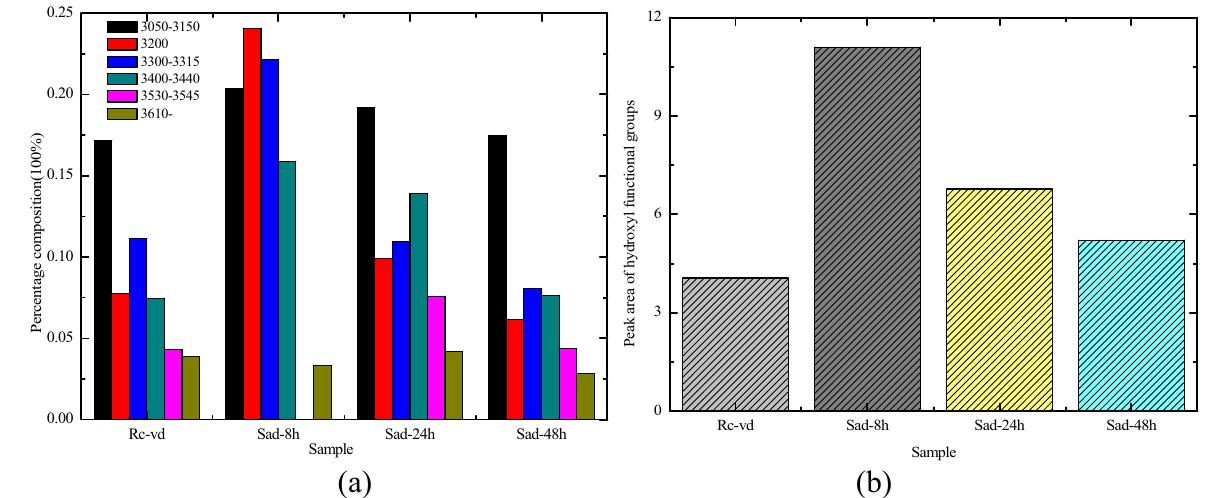
Figure 8. Content distribution of the various functional groups of the 3000–3600 cm −1 band and total area of the –OH. ( a ) Percentages of different functional groups ( b ) Total area of